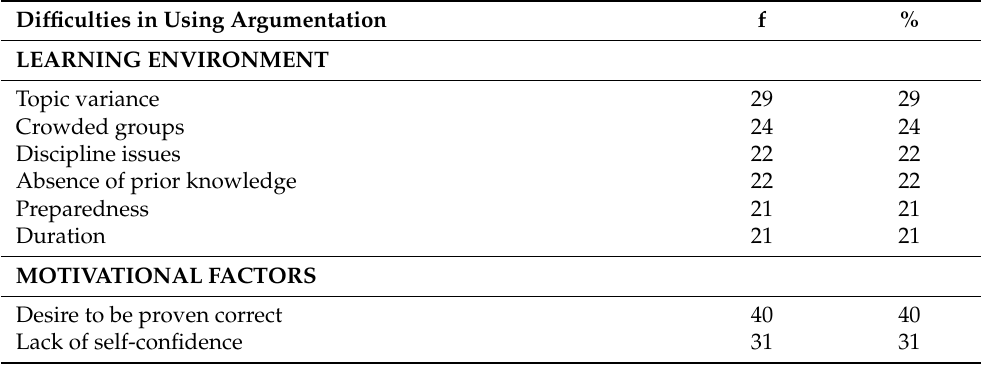
Table 2. Themes and codes under “Difficulties in Using Argumentation”